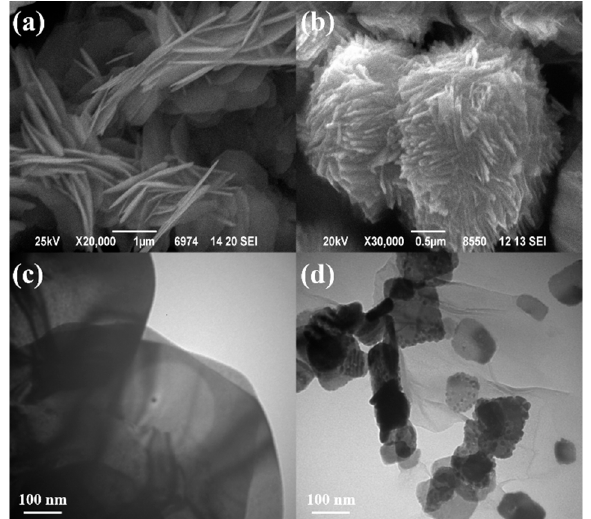
Figure 4. The FTIR spectrum of BiOBr and BiOBr-G nanocomposites.